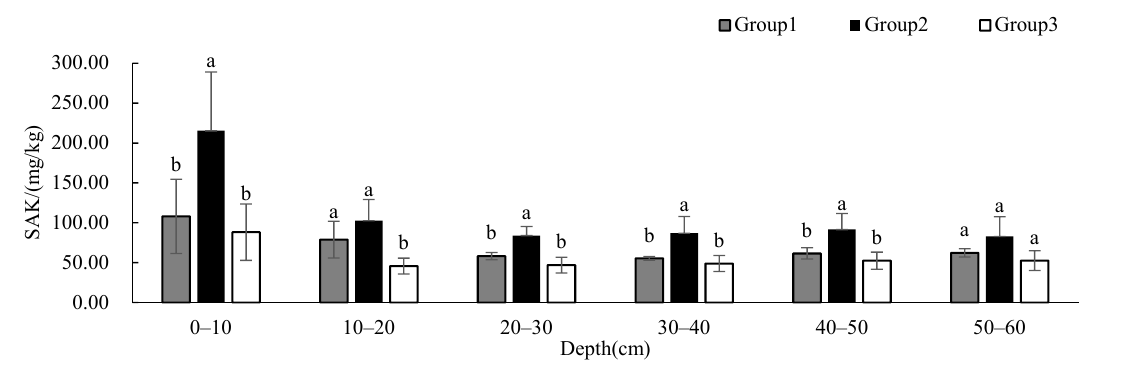
Figure 13. One-way ANOVA results of SAK under different vegetation cover types at different depths ( p < 0.05; a > b).